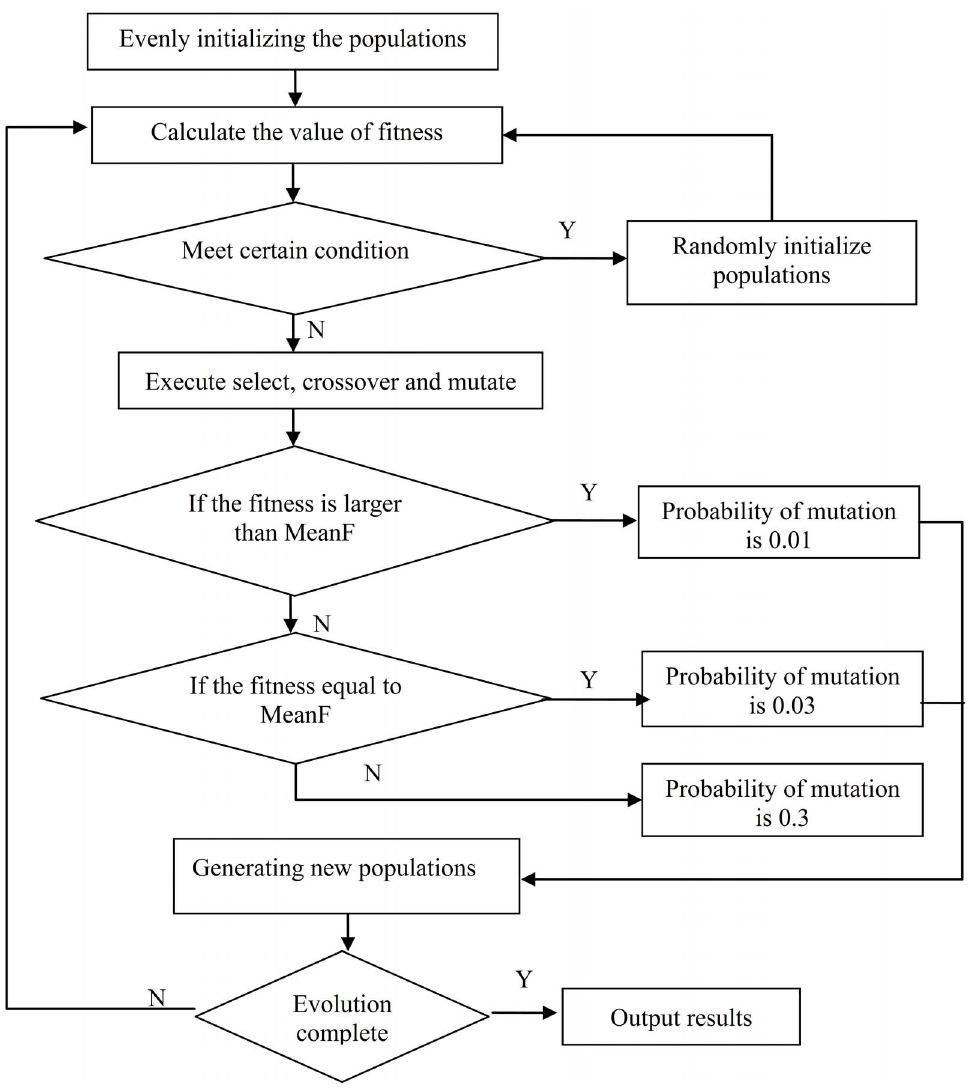
Figure 3. Algorithm process flow. doi:10.1371/journal.pone.0072180.g003 constraints in Table 1. Table 2 data are the free energy gaps that satisfy the WWL, WCL, and GC content combinatorial constraints. Data in parentheses are the free energy gaps that satisfy the WWH, WCH, and GC content combinatorial constraints in Table 2.